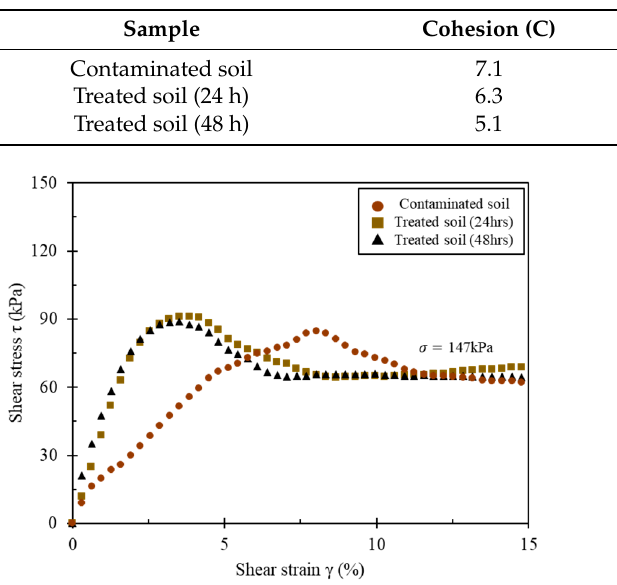
Figure 10. Comparison of shear strain–shear stress responses at σ = 147 kPa.